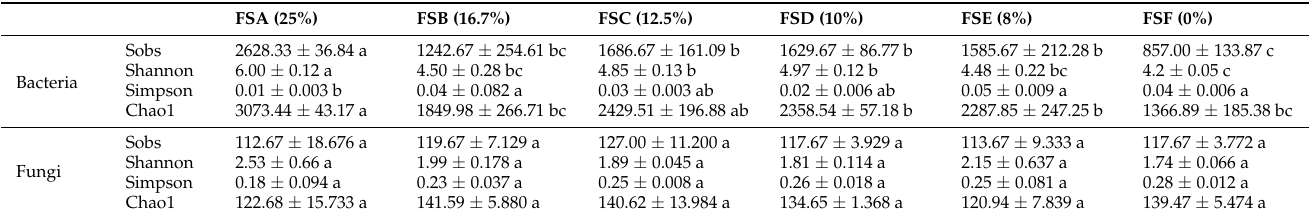
Table 3. Alpha diversity index of the microbial community in saline-alkali soil improved by different treatments. For each row, the means ± SD with different letters were significantly different between treatments ( p < 0.05, using the HSD test).